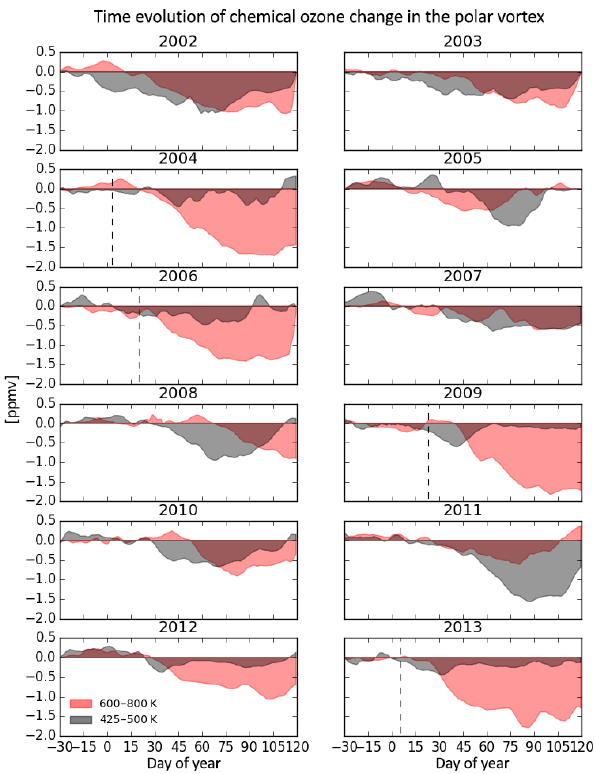
Figure 1. Time evolution of the estimated ozone change in the vor- tex, in volume mixing ratio, for each Arctic winter from 2002 to 2013. The equivalent latitude of 70 ◦ N has been used to define the polar vortex border. The gray and red areas show the average of vor- tex mean ozone change in the lower stratosphere (425–500K) and in the mid-stratosphere (600–800K), respectively. The dashed lines in 2004, 2006, 2009 and 2013 indicate the central date of the sud- den stratospheric warmings, which are used as a reference date to calculate the composite discussed in Sect.